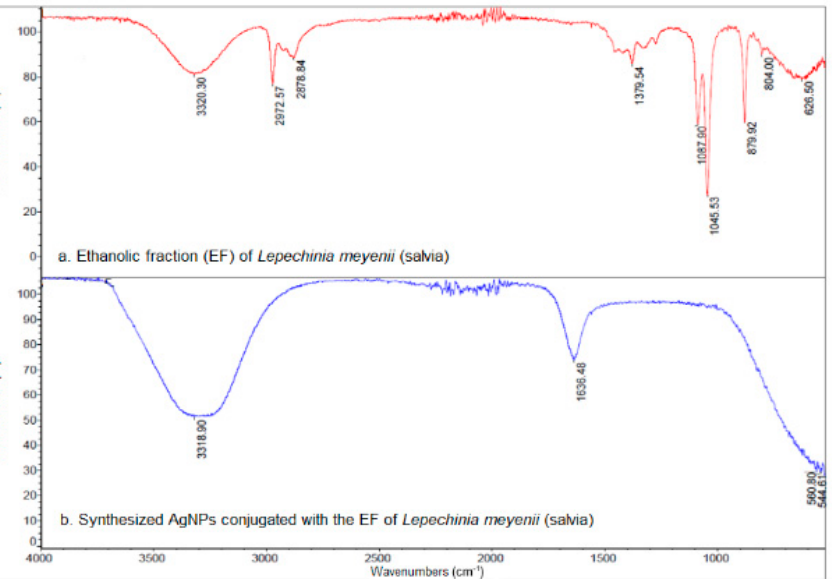
Figure 3. FT-IR spectra of the ( a ) ethanolic fraction (EF) and the ( b ) synthesized AgNPs conjugated with the ethanolic fraction of Lepechinia meyenii (salvia).